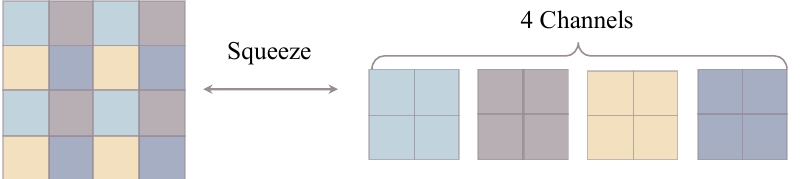
Figure 4. The Squeeze operation downscales latent representations according to a checkerboard